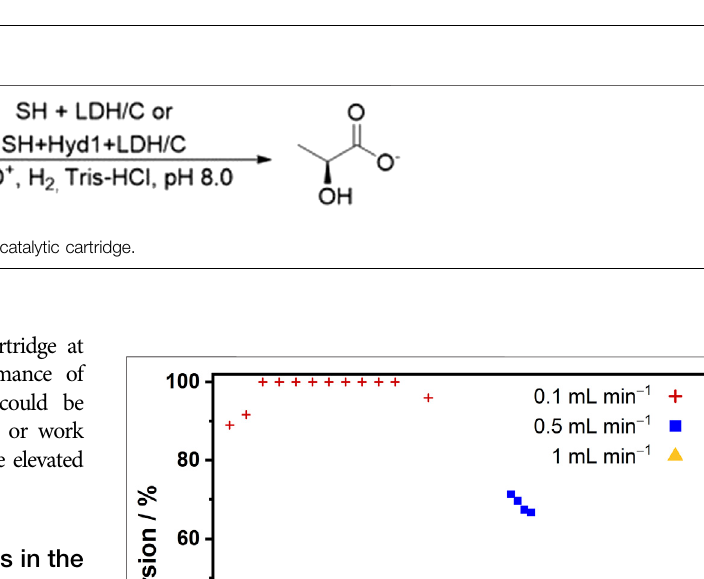
fl ow rate (cid:1) 0.6 ml min − 1 , t (cid:1) 17 s, reactor 2 Res